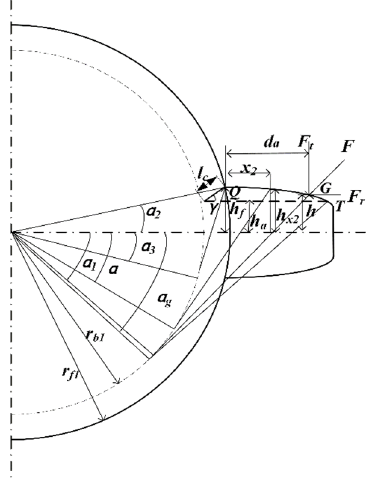
Figure 3 is the schematic diagram of helical gear transverse face with crack fault.